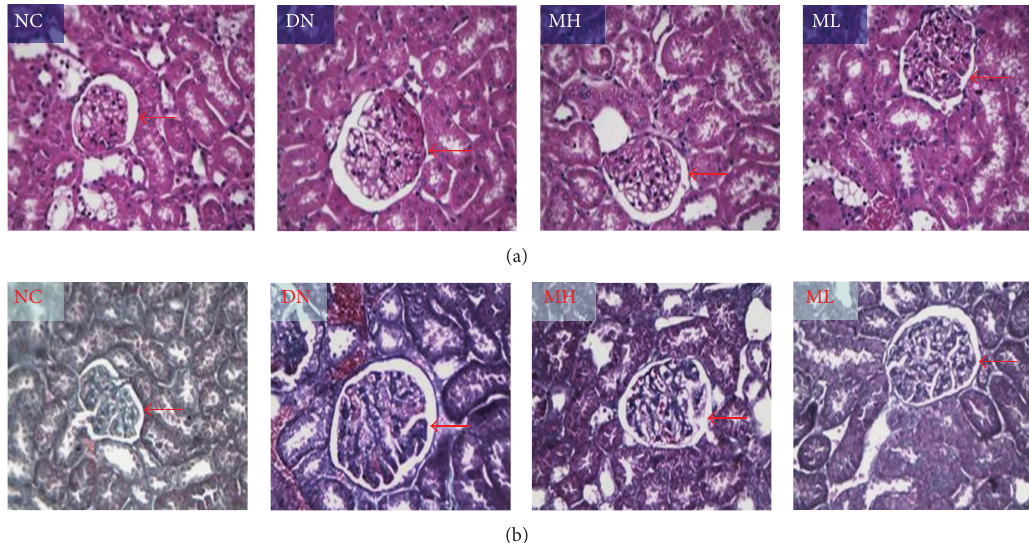
Figure 1: Changes of renal pathology observed by light microscopy. (a) HE staining ( × 200). (b) Masson staining ( × 200). The glomerular volume (red arrow) was greater in the experimental group than in the NC group, whilst renal tubular edema, abnormal glomerular mesangial deposition, and atrophy and degeneration of renal glomeruli were observed in the experimental groups, although changes were significantly less in the MH group.